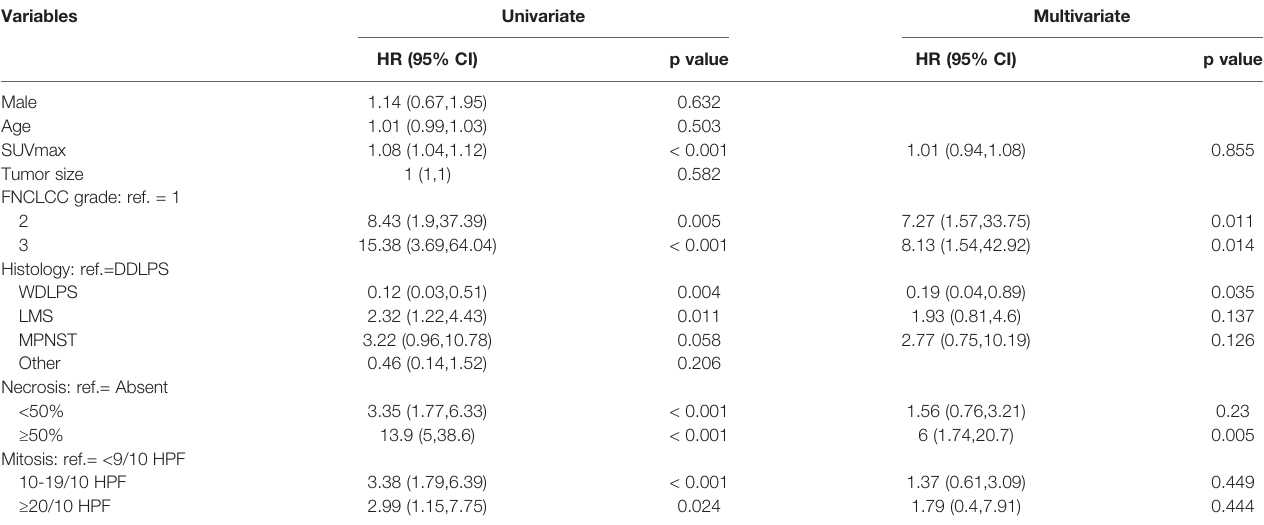
TABLE 3 | Univariate and multivariate analyses of risk factors associated with local recurrence.